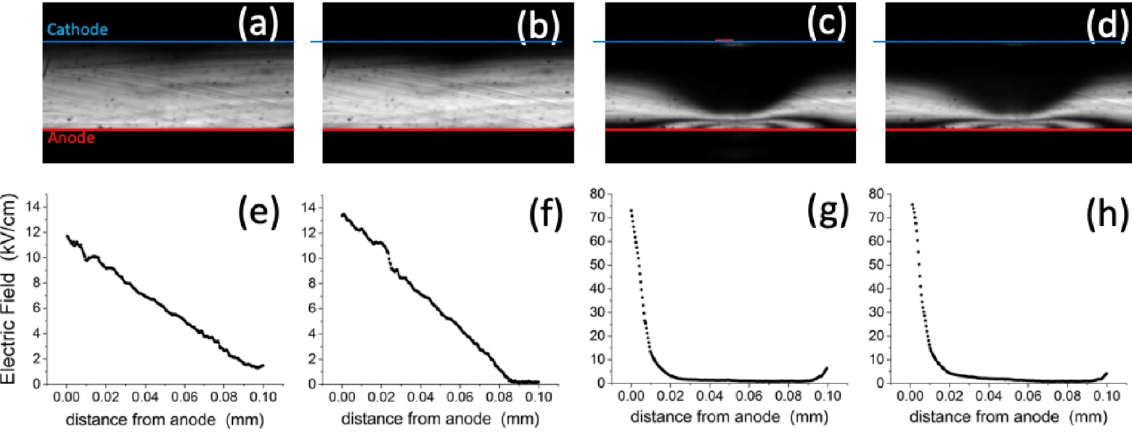
Figure 3. Pockels image at specific times (marked with red points in Figure 2): after the bias ramp reached 600 V ( a ), just before the optical perturbation ( b ), at the end of the irradiation interval, which lasts 5 min ( c ), and 15 min after the end of the irradiation ( d ). For the same times, ( e – h ) report the central profiles of the vertical electric field at the transverse coordinate x irr of irradiation (center of